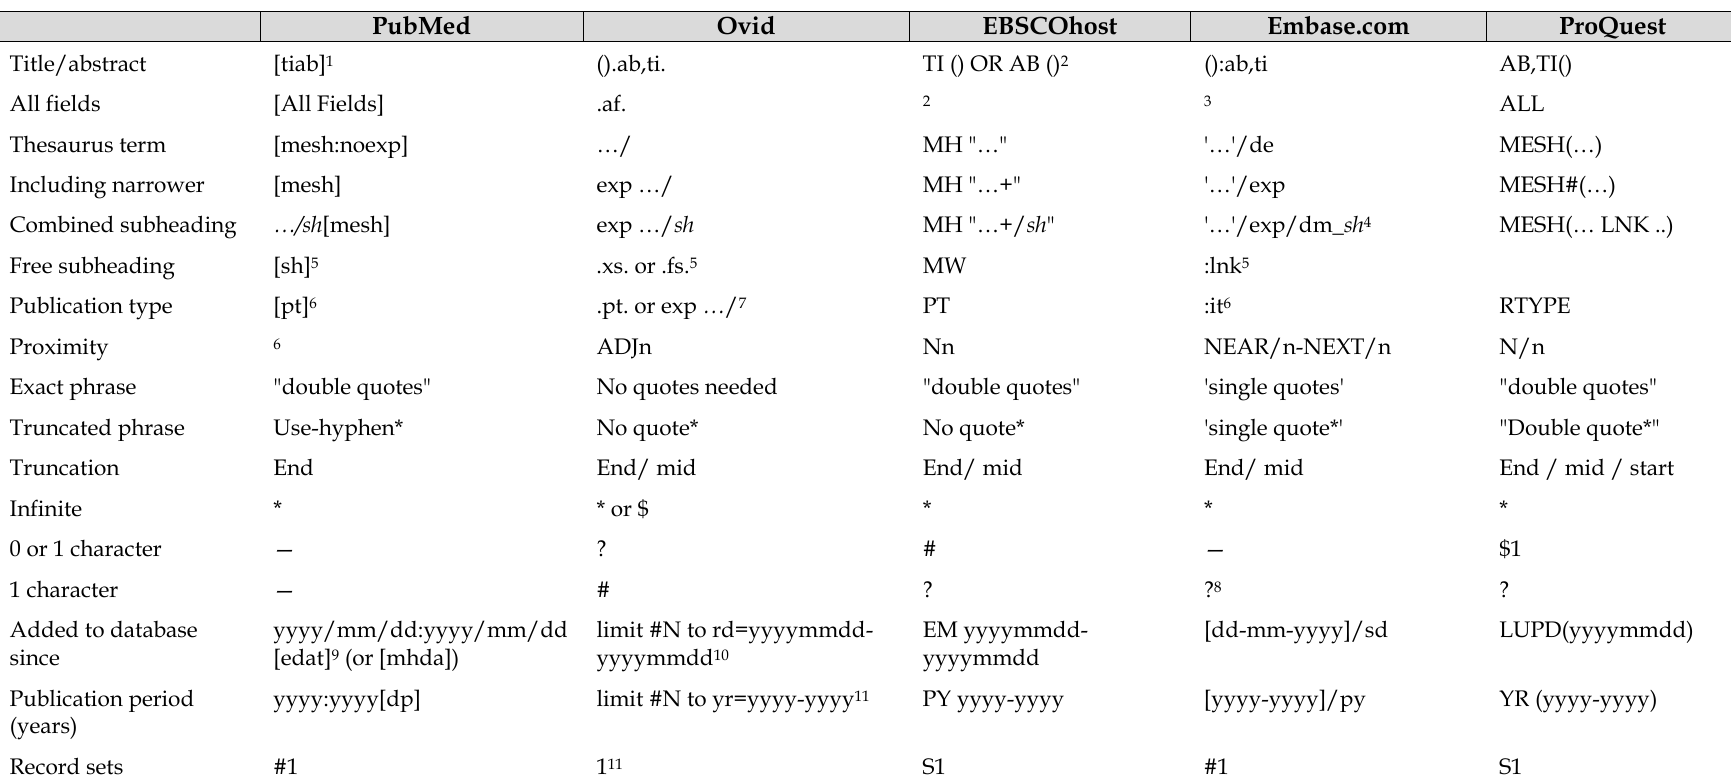
Table 1 Field codes in five most used interfaces for biomedical literature